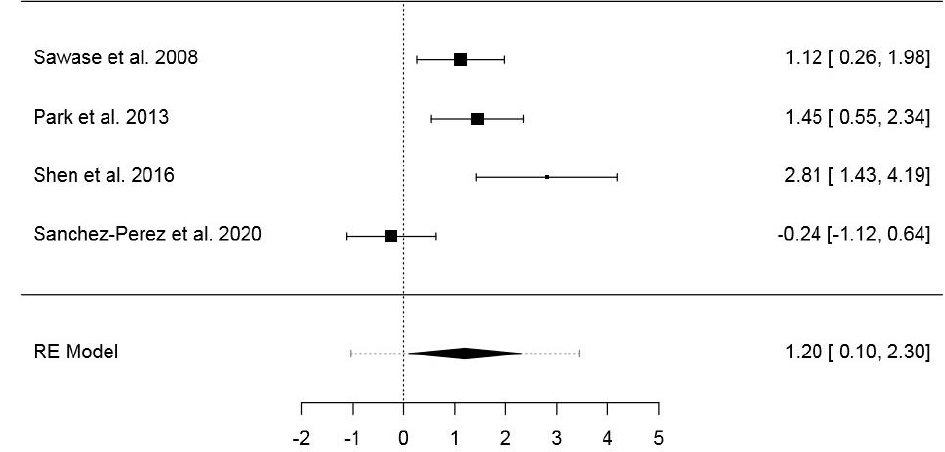
Figure 3. Forest plot for the random-effects model with the DerSimonian – Laird estimator in the first dataset (effects size: standardized mean difference of the bone – implant contact).